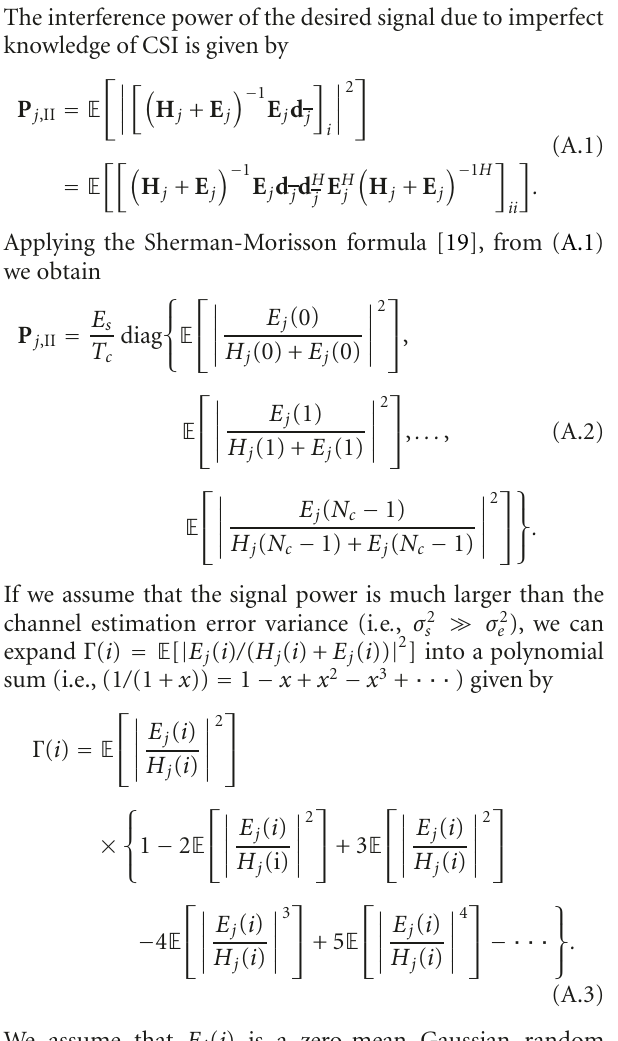
Figure 9: Impact of f D T s